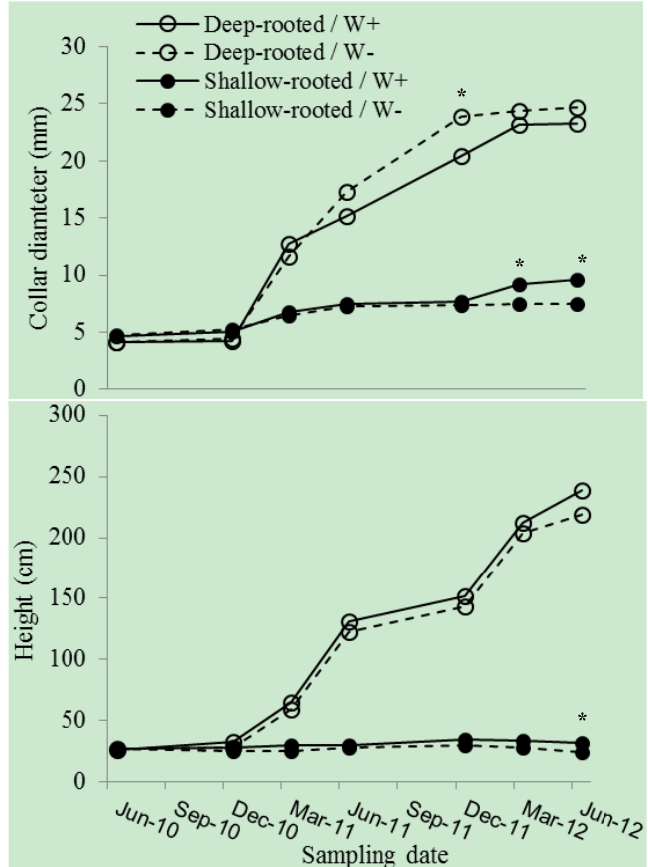
Figure 3. Mean values ± SE of ( a ) collar diameter (mm) and ( b ) shoot height (cm) of deep-rooted ( Q. saponaria , white circles) and shallow-rooted ( C. alba, black circles) saplings growing in the field under different water availability treatments (W+: solid line; W−: dashed line). Data were obtained during two growing seasons, specifically in June 2010, December 2010, March 2011, June 2011, December 2011, March 2012, and June 2012. Asterisks indicate significant differences at p < 0.05 (Student’s t